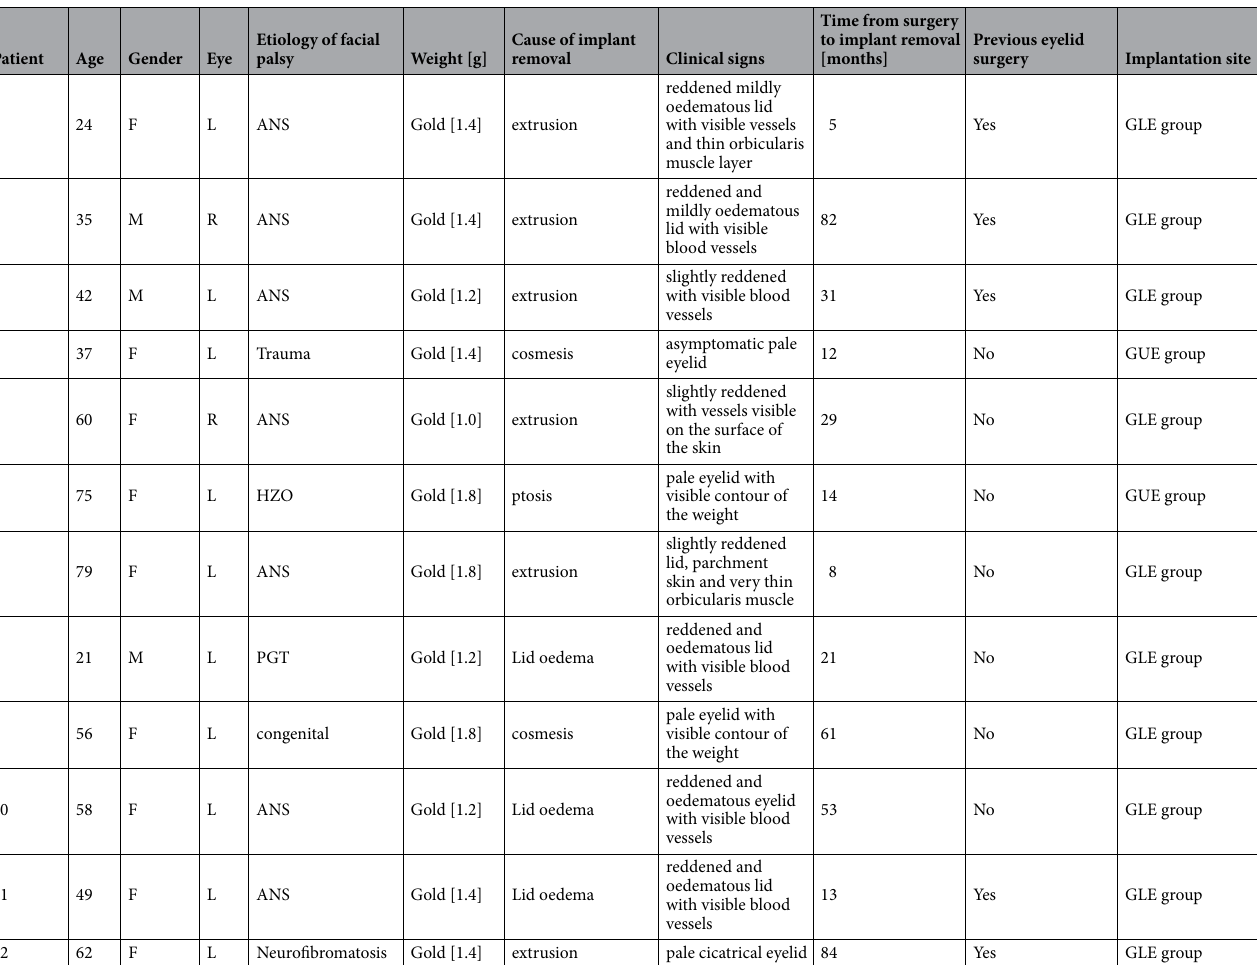
Table 1. Clinical data. ANS acoustic neuroma surgery, HZO Herpes zoster ophthalmicus, PGT parotid gland tumor. GLE group = received a gold weight fixed to the tarsus 2 mm above the upper eyelid margin.